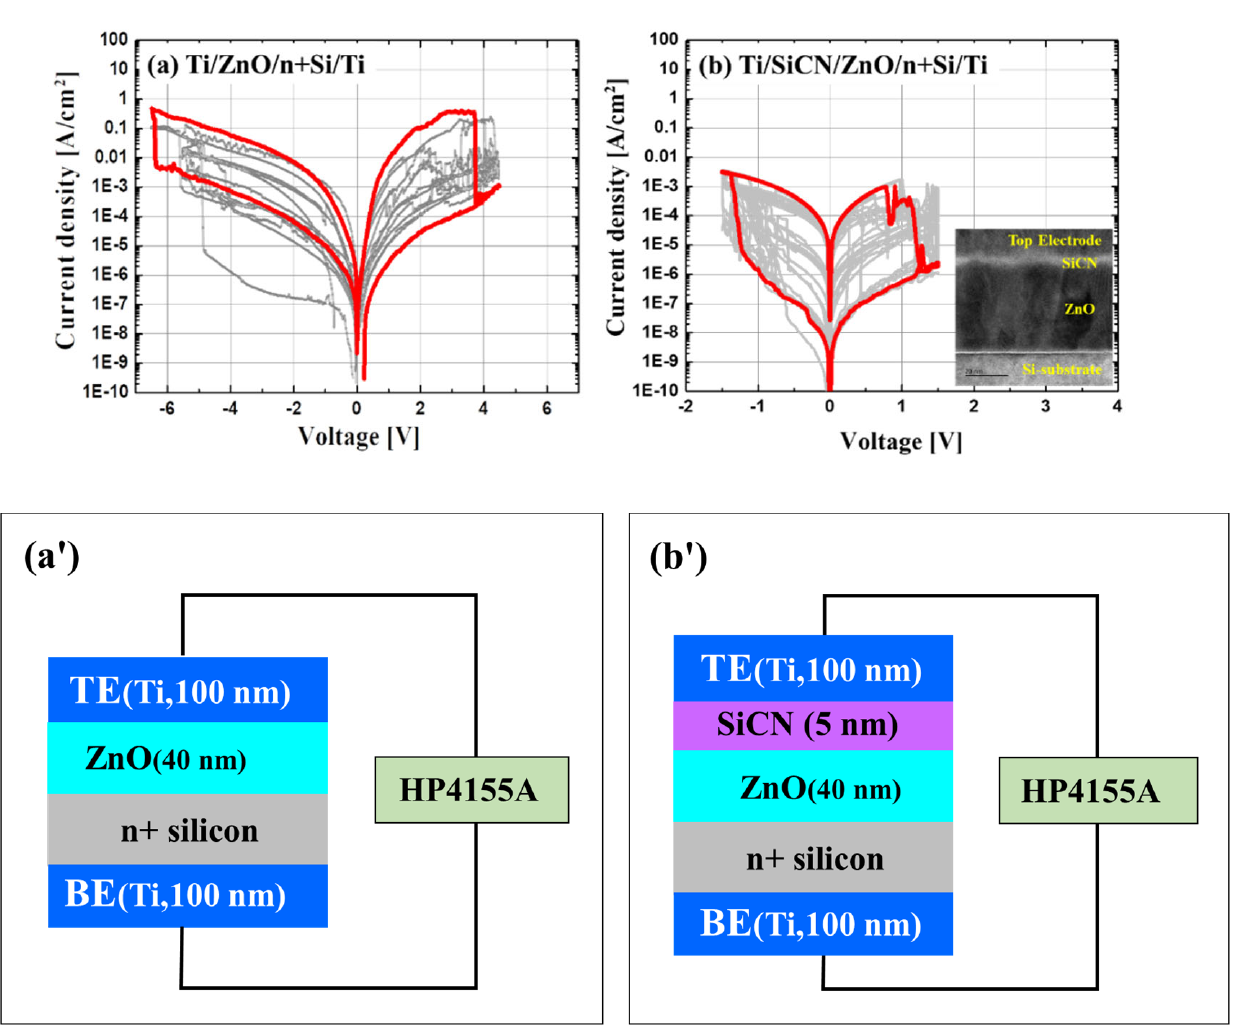
Figure 15. The IV measurements of the fabricated devices with ( a ) ZnO only and ( b ) ZnO/SiCN ( a ʹ ) and ( b ʹ ) schematic section view of ( a ) and ( b ), respectively. Inset of ( b ) is TEM image of RRAM with ZnO/SiCN.